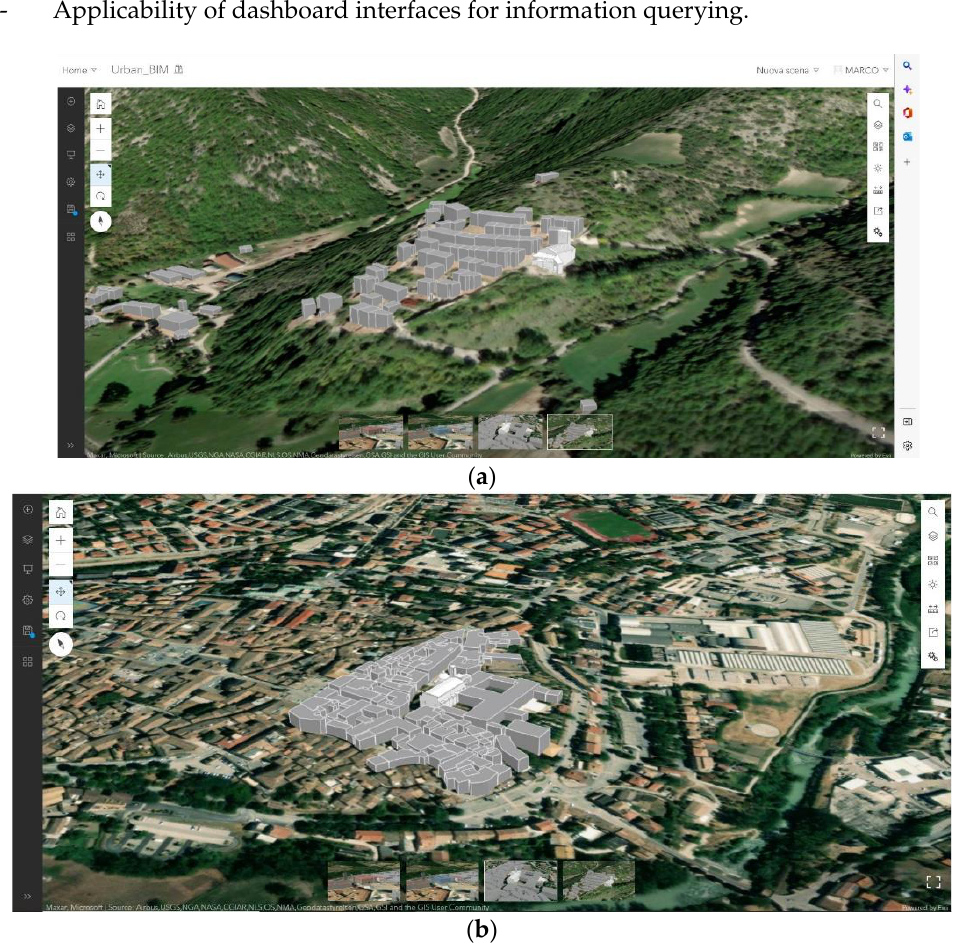
Figure 17. 3D view on two of the four geographic spot in the ArcGIS WebApp: ( a ) Campi di Noria with Sant’Andrea church ; and ( b ) Tolentino with San Nicola